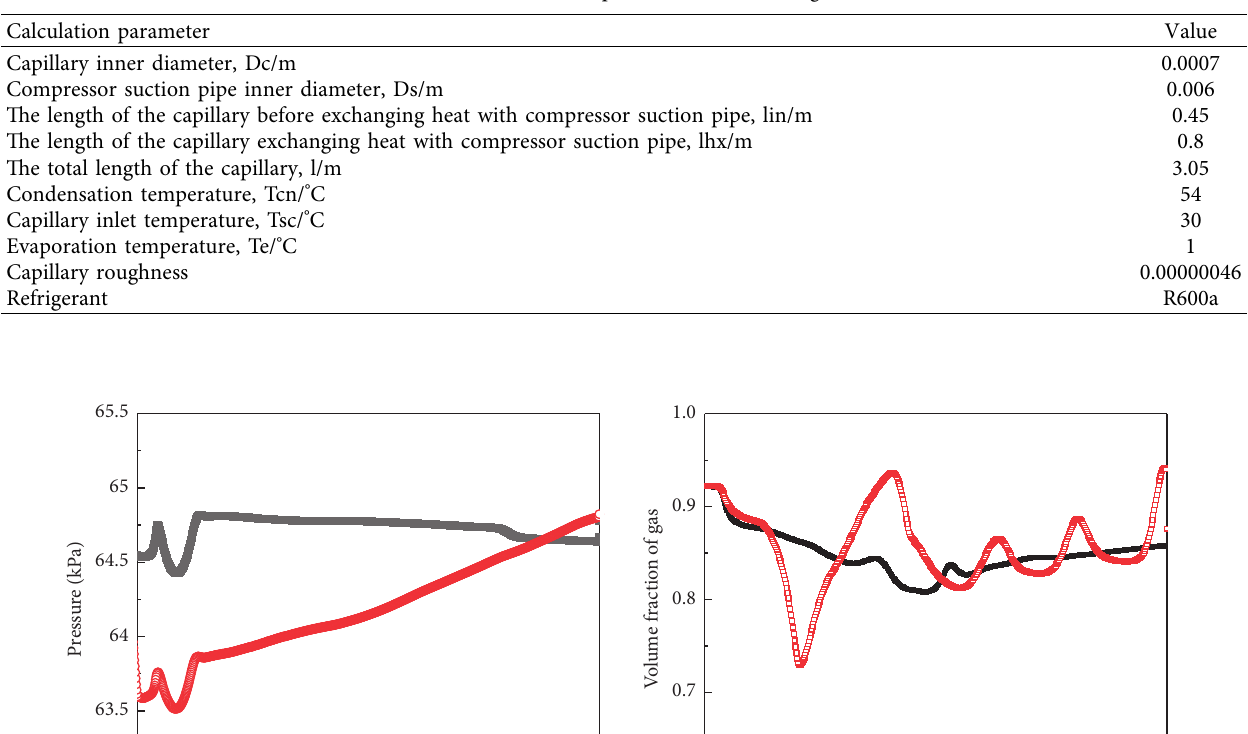
Table 1: The calculation parameters of the refrigerator.